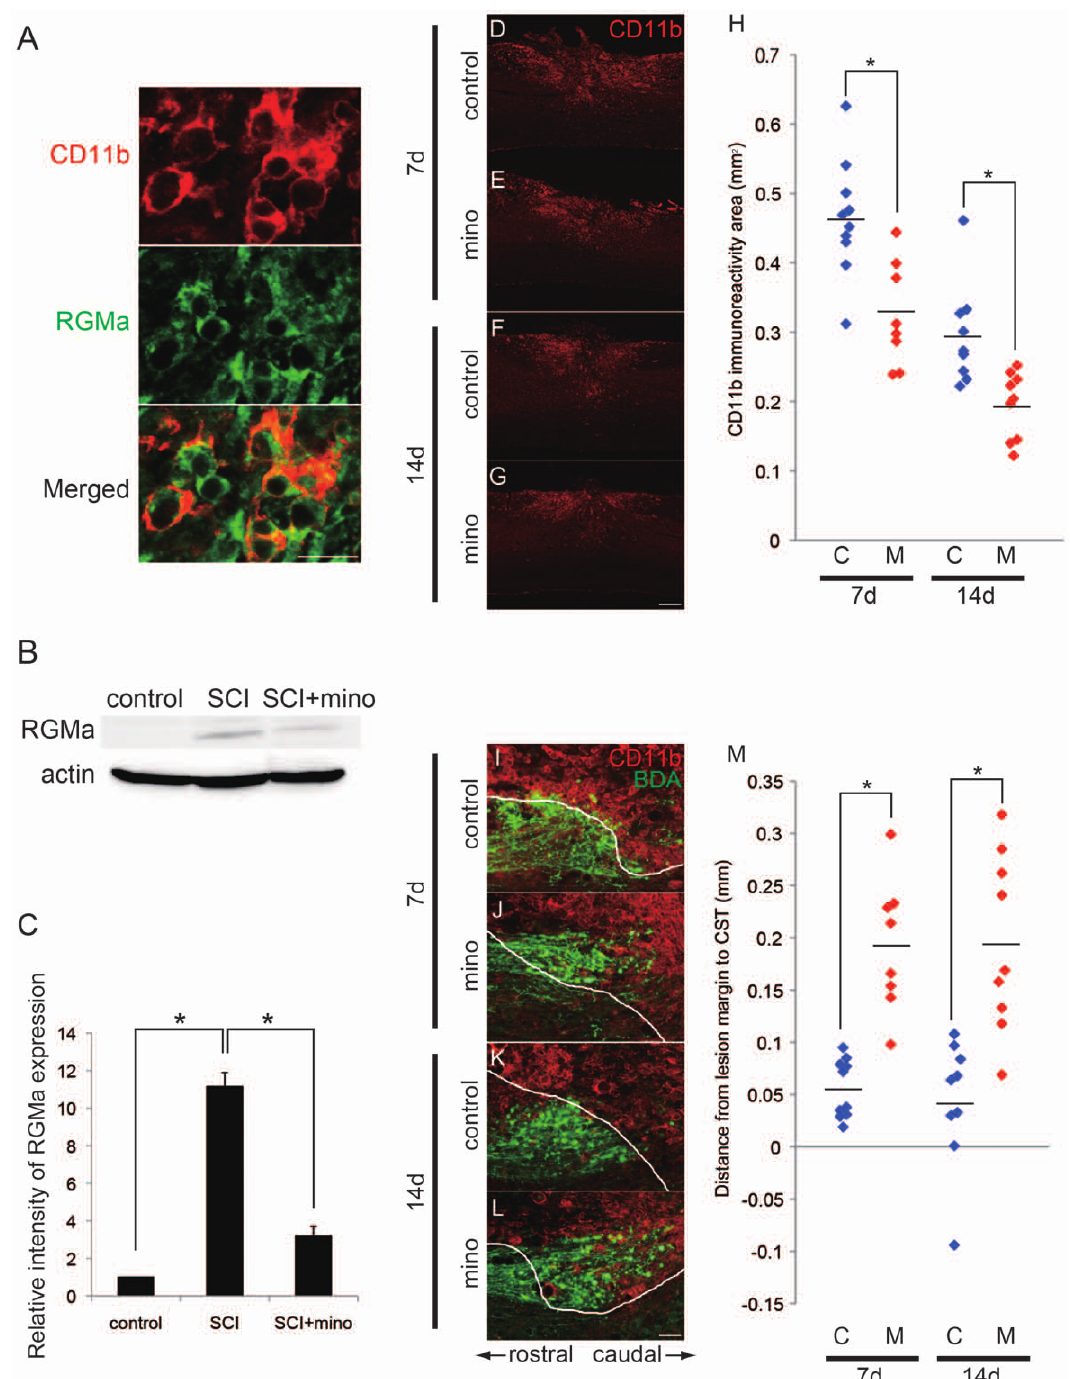
Figure 5. Blockage of micloglial activation by minocycline inhibits CST dieback with the reduction of RGMa expression after SCI. A , Expression of RGMa (green) by CD11b-positive microglia (red) in the lesion epicenter at 7 days after SCI. Scale bar: 20 m m. B , C , Changes in RGMa expression in response to SCI (day 7) and treatment with minocycline (n=3). * p , 0.01 (one-way ANOVA followed by Tukey-Kramer test). D – G , Changes in the number of CD11b + cells (red) in an SCI lesion site at 7 ( E ) and 14 (G) days after treatment with minocycline. These patterns differ from those observed after treatment with the control vehicle only ( D , F ). Scale bar: 500 m m. H , Results of quantitative analyses investigating CD11b-positive area in minocycline-treated group (M) and vehicle-treated control (C) (7d, C, n=10; M, n=8; 14d, C, n=9; M, n=9). * p , 0.05 (Student’s t- test). I – L , Comparison of the effects of minocycline administration ( J , L ) and control vehicle treatment ( I , K ) on CST dieback at 7 and 14 days, respectively. CST axons (BDA, green) and the accumulating microglial cells (CD11b, red). White line indicates the margin of lesion (see Materials and methods). Scale bar: 100 m m. M , Quantitative analyses of CST dieback by minocycline treatment (M) and vehicle-treated control (C) (7d, C, n=10; M, n=8; 14d, C, n=9; M, n=9). Data are represented as mean 6 SEM. * p , 0.05 (Student’s t- test).